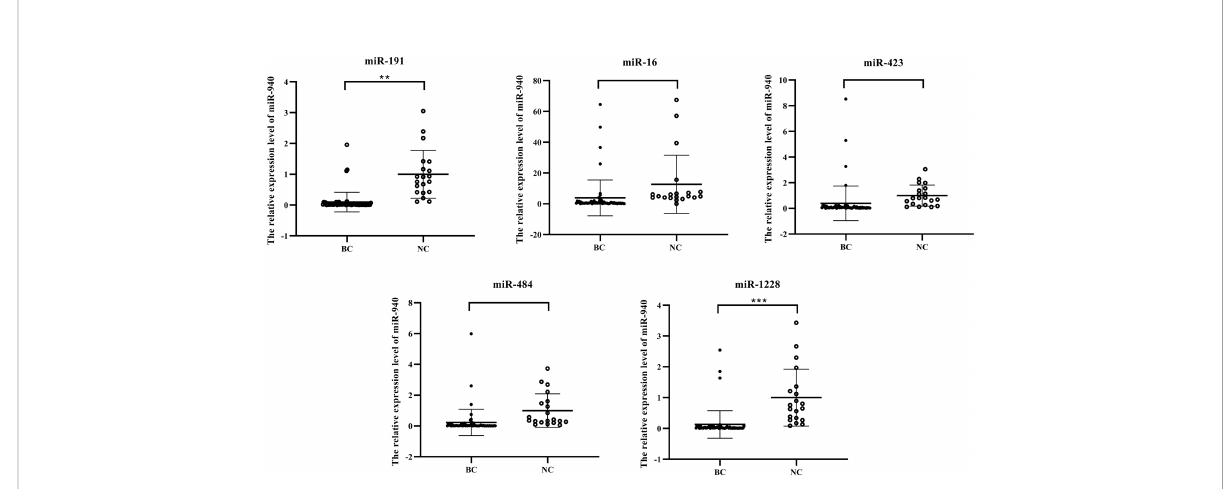
FIGURE 4 Results from normalization using the candidate internal reference miR-940. (*p<0.05, **p<0.01, ***p<0.001, no signi fi cance, ns